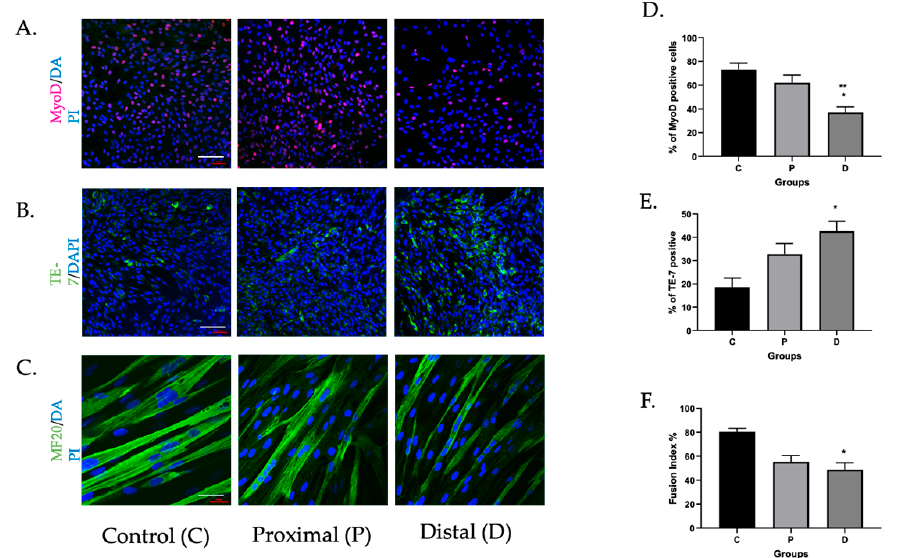
Figure 1. Myoblasts harvested from ischemic muscle had attenuated differentiation compared to those from perfused segments. Myoblasts harvested from proximal (P) and distal (D) segments of muscle affected by PAD (N = 4) were compared to those from perfused controls (C) (N = 2) for markers of muscle or fibroblast origin, and differentiated over five days. ( A , D ) MyoD (* p < 0.03, ** p < 0.002, distal vs. proximal and control, respectively); ( B , E ) TE-7 (* p < 0.03, distal vs. control). Myocyte fusion index (MFI); ( C , F ) calculated by dividing the number of nuclei within multinucleated MF20-positive cells (>2) by the total number of nuclei (* p = 0.03, ischemic vs. control). Images are representative. Scale bar = 10 μ M.